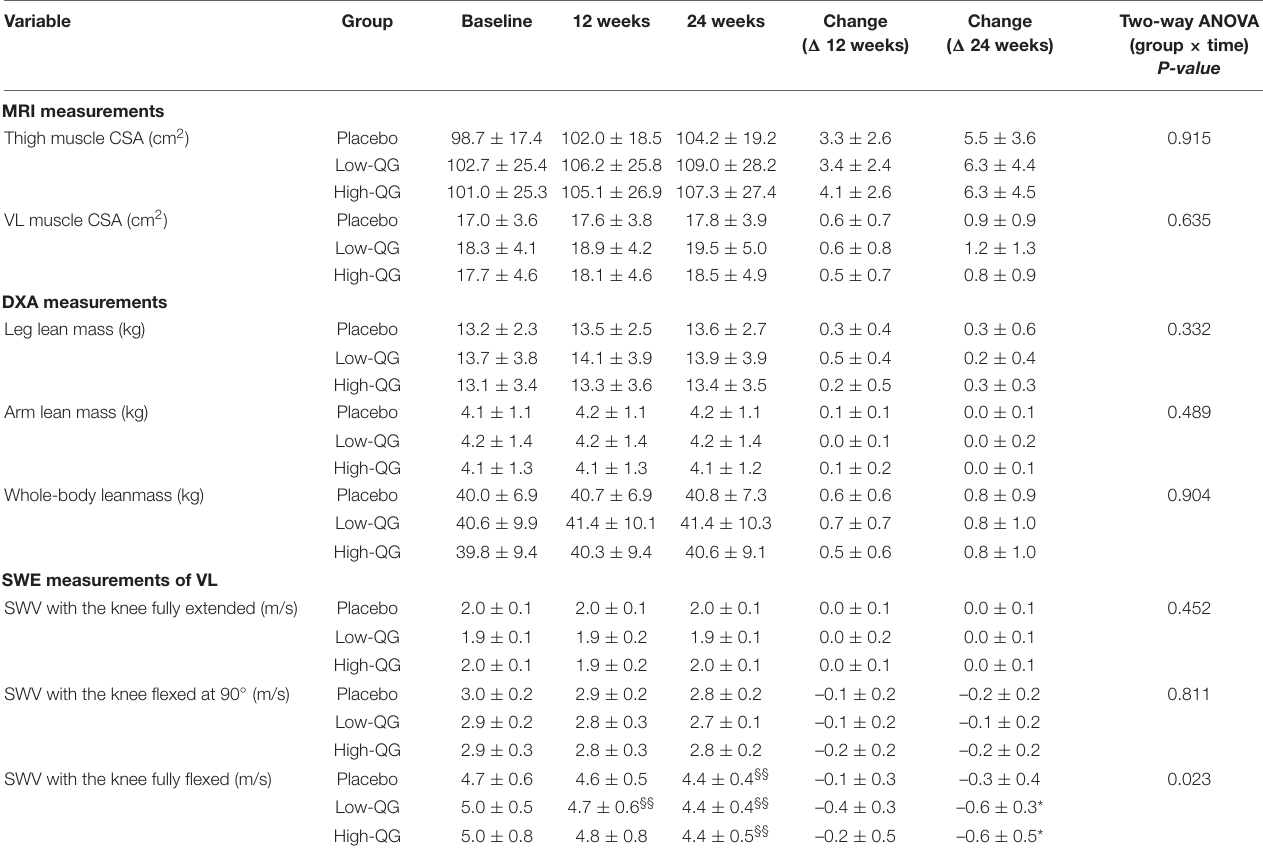
TABLE 2 | Effects of the intervention on muscle quantity and stiffness in the PPS analysis. Variable Group Baseline